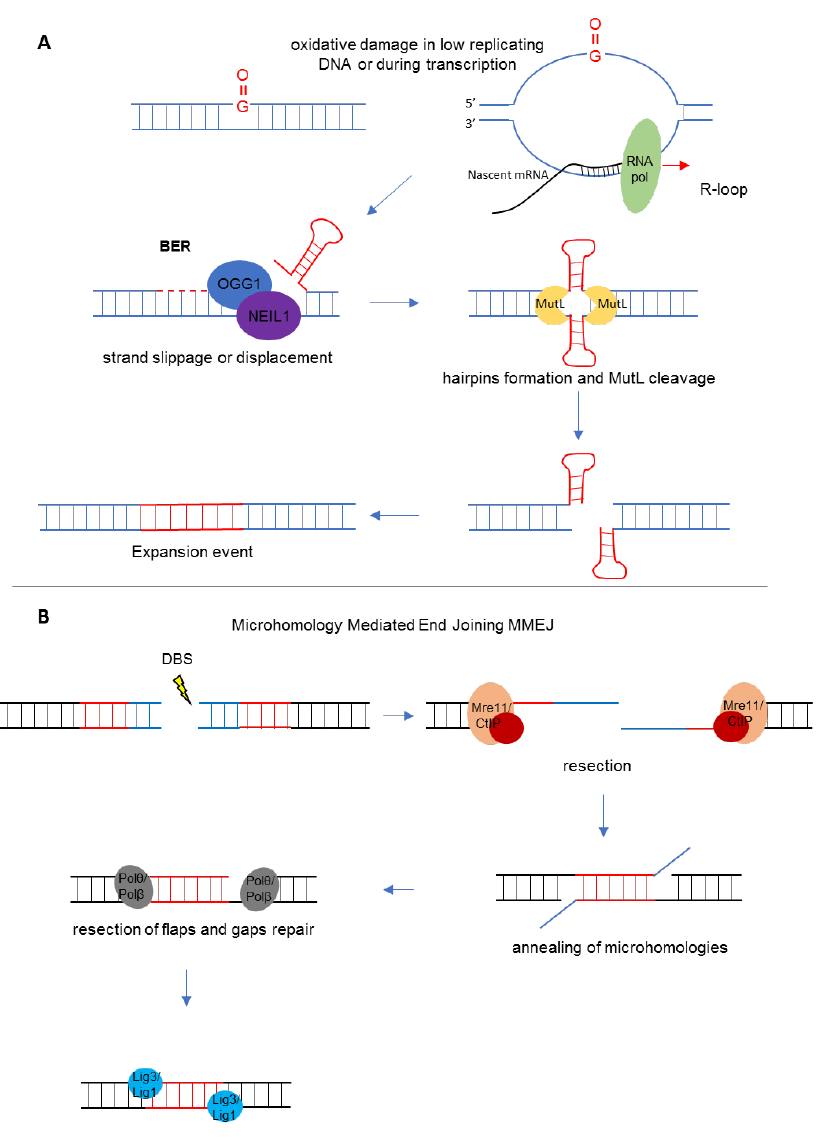
Figure 3. Proposed mechanisms of CGG instability in tissues with low rate of cell division. ( A ) Oxidation of guanine in DNA strands or during transcription in the displaced DNA strand of the R loop activates BER mechanisms through the recruitment of OGG1 and NEIL1 enzymes, that remove the anomalous base. This damage generates a displacement of the DNA strand favoring hairpin formation. MutL enzymes bind the region containing hairpins in an attempt to remove them; the resulting cleavage produces a DSB which will be repaired, causing the repeat expansion. ( B ) Large contraction events could be addressed by MMEJ repair mechanism. A DSB may expose sequences of microhomology (MH, in blue) at both sides of the break, which may anneal through the removal of nonhomologous flaps at both ends. Pol θ /Pol β complex will fill the gaps, which will be ligated by Lig3 and Lig1, resulting in